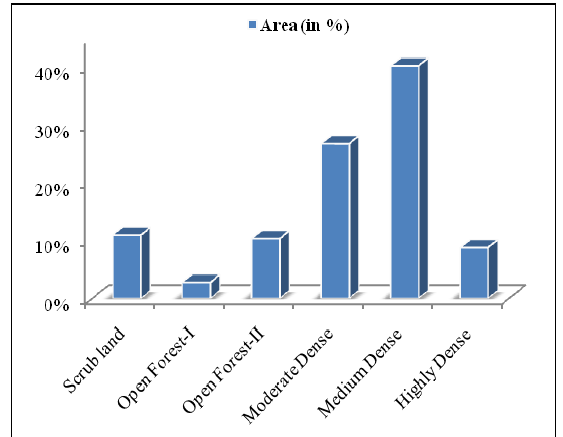
Figure 4. Percentage area of FCD classes